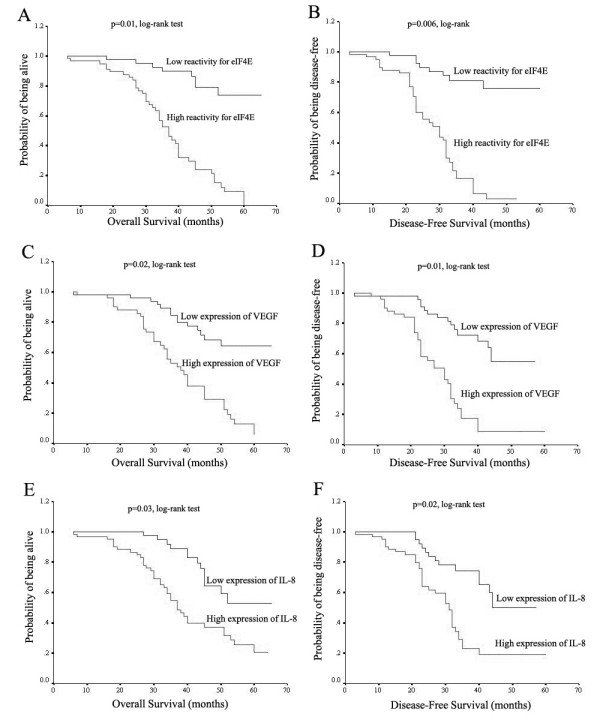
Comparison of overall as well as disease-free survival using the Kaplan-Meier analysis between the groups of patients with low and high eIF4E, VEGF and IL-8 protein expression.